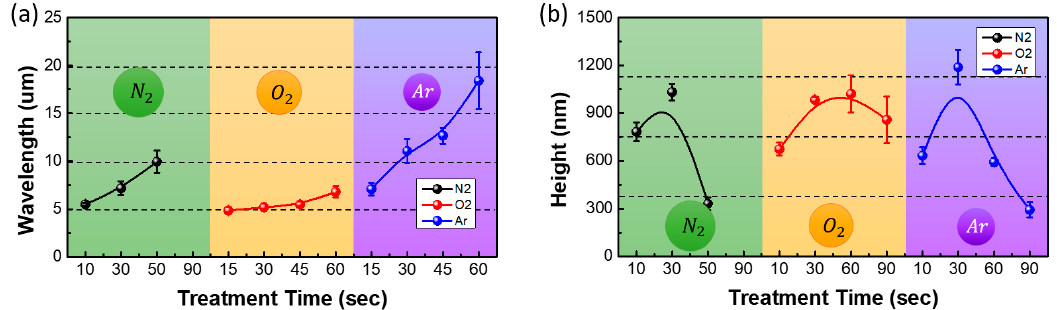
Figure 11. Variation of the ( a ) wavelengths and ( b ) heights of the wrinkles with the treatment times (10–90 s) of the nitrogen, oxygen, and argon plasma treatment.